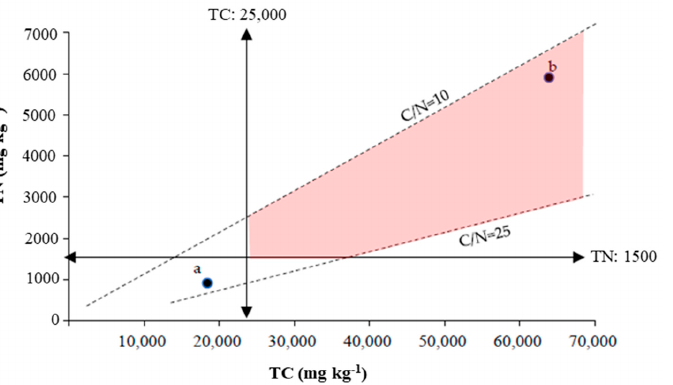
Figure 3. Values of total C and total N in (a) the organic, (b) the chemical fertilizer treatments ( n = 2). Light red zone corresponds to the recommended values of TC, TN, and C/N ratio for achieving a high level of nutrient circulation activities [15,26,27].